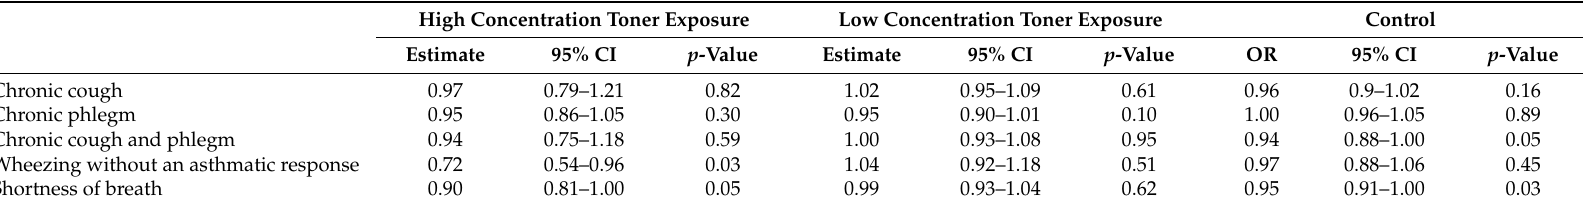
Table 5. E ff ects of toner exposure concentration on respiratory symptoms and odds ratio for respiratory symptoms in the control